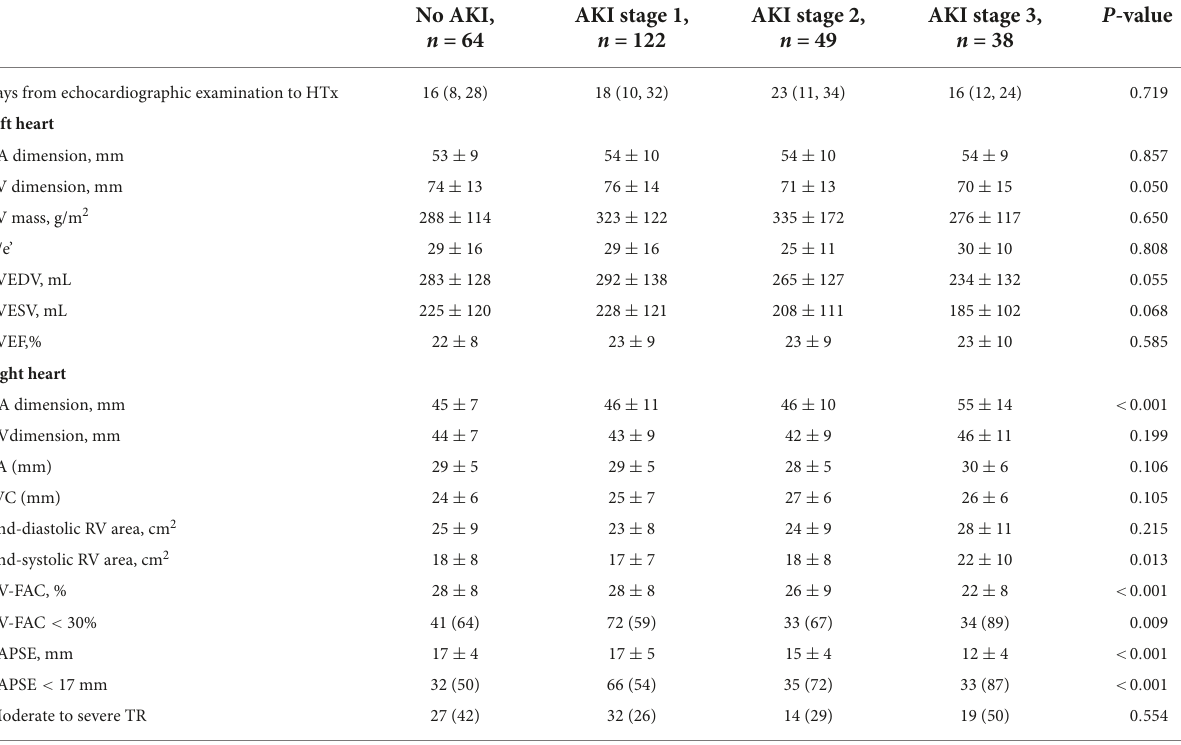
determine the relationship between RV function